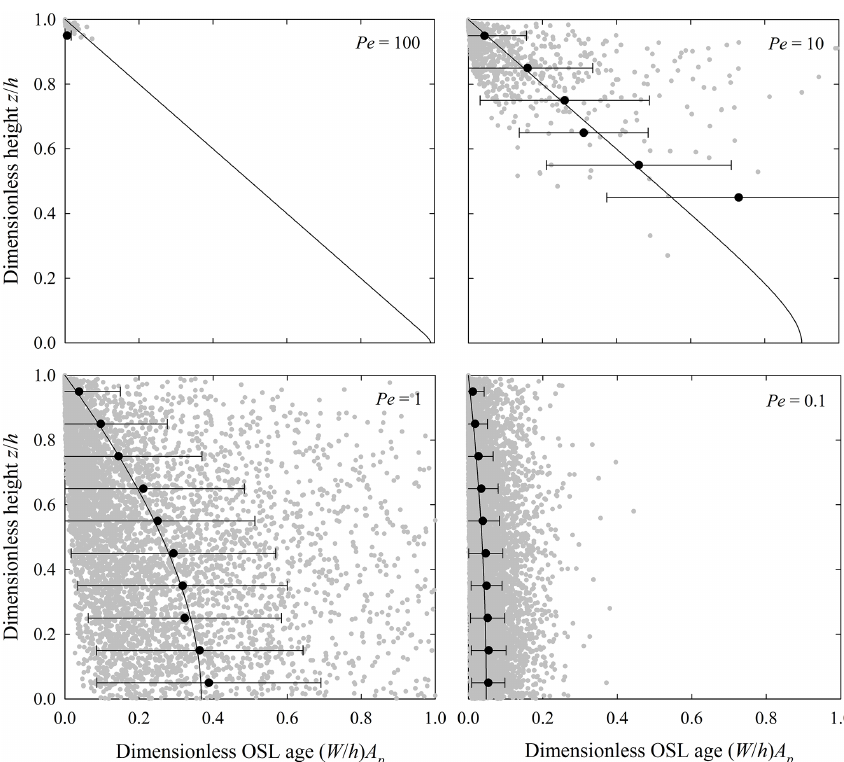
Figure 6. Plot of dimensionless OSL age ˆ A p = ( W/h ) A p versus dimensionless height ˆ z = z/h showing simulated particle ages ˆ A p (gray dots) for Pe = 100, 10, 1, 0.1, and estimates of expected values ˆ m 1 averaged within 0 . 1 h intervals (black circles) with one standard deviation bars. Simulations represent uniform mixing with κ z = K z . Solid line is the theoretical